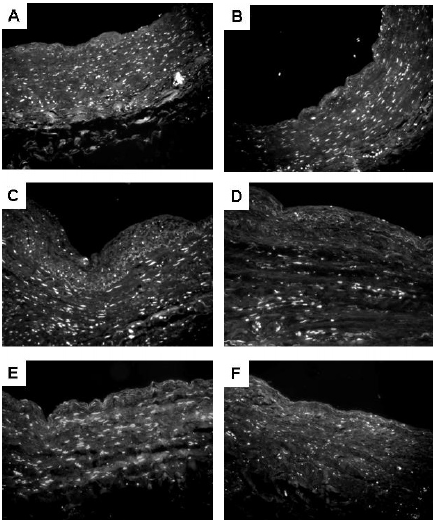
Figure 3 - Hoechst 33258 nuclei stain of human saphenous vein cultured in the ex vivo perfusion system. The segments were cultured under venous (A, C, E) and arterial (B, D, F) hemodynamic conditions for 1 (A, B) , 2 (C, D) or 4 (E, F) days. 100X